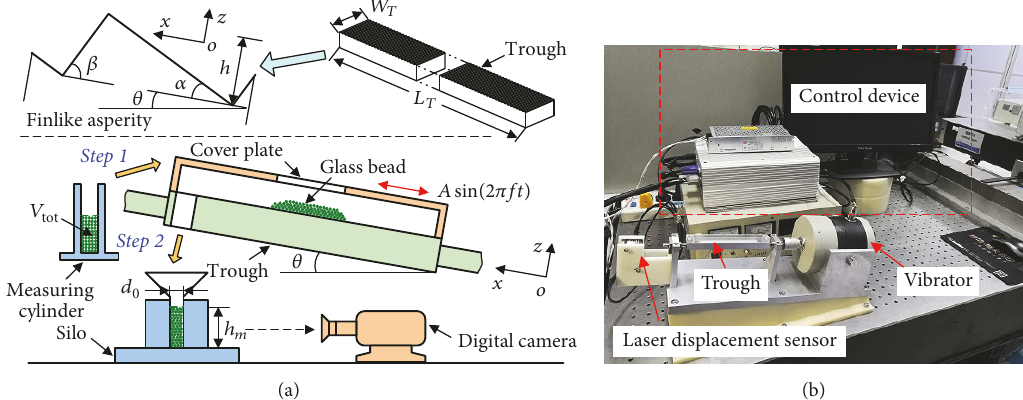
Figure 4: Sketch of the experimental conditions. (a) The trough with finlike asperities and the main experimental process. (b) Experimental equipment for vibratory conveyance.